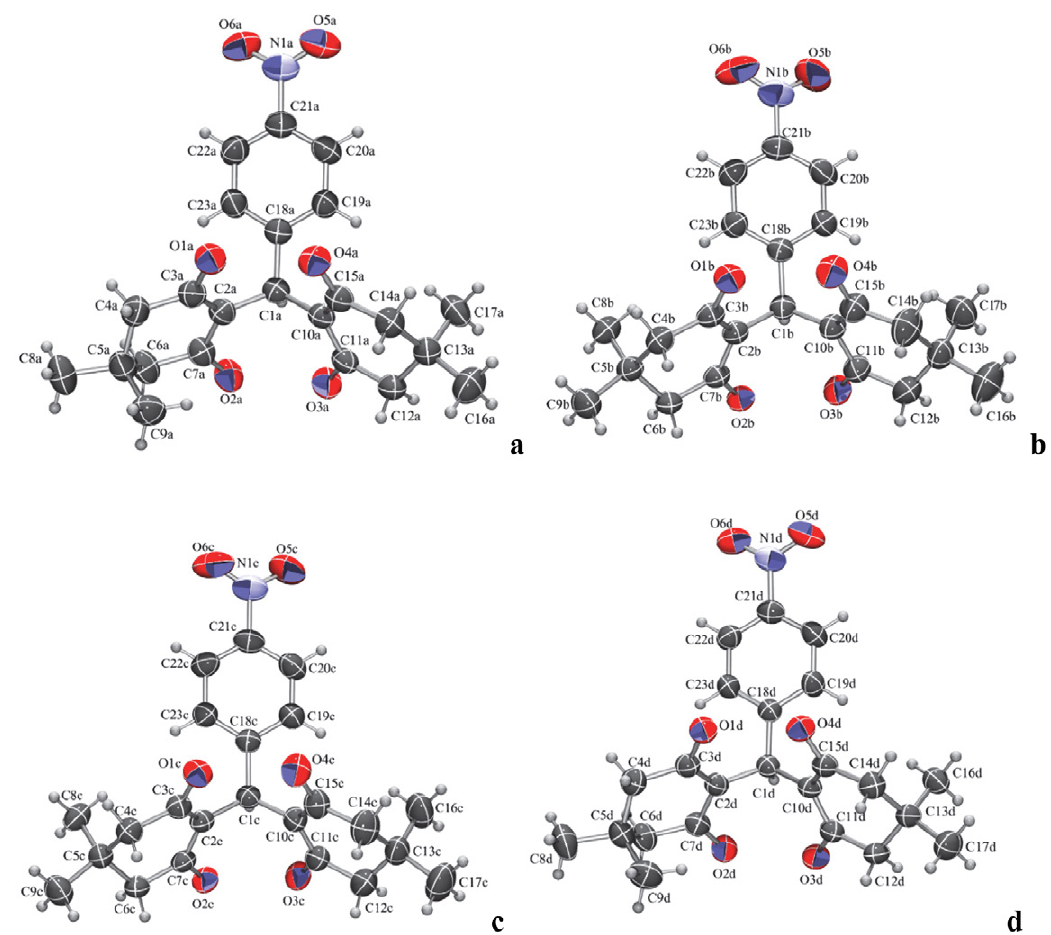
Figure 4. ORTEP-3 drawings of four symmetry-independent molecules in 1 with atom numbering schemes. Displacement ellipsoids are drawn for the probability of 50% and hydrogen atoms are shown as spheres of arbitrary radii.